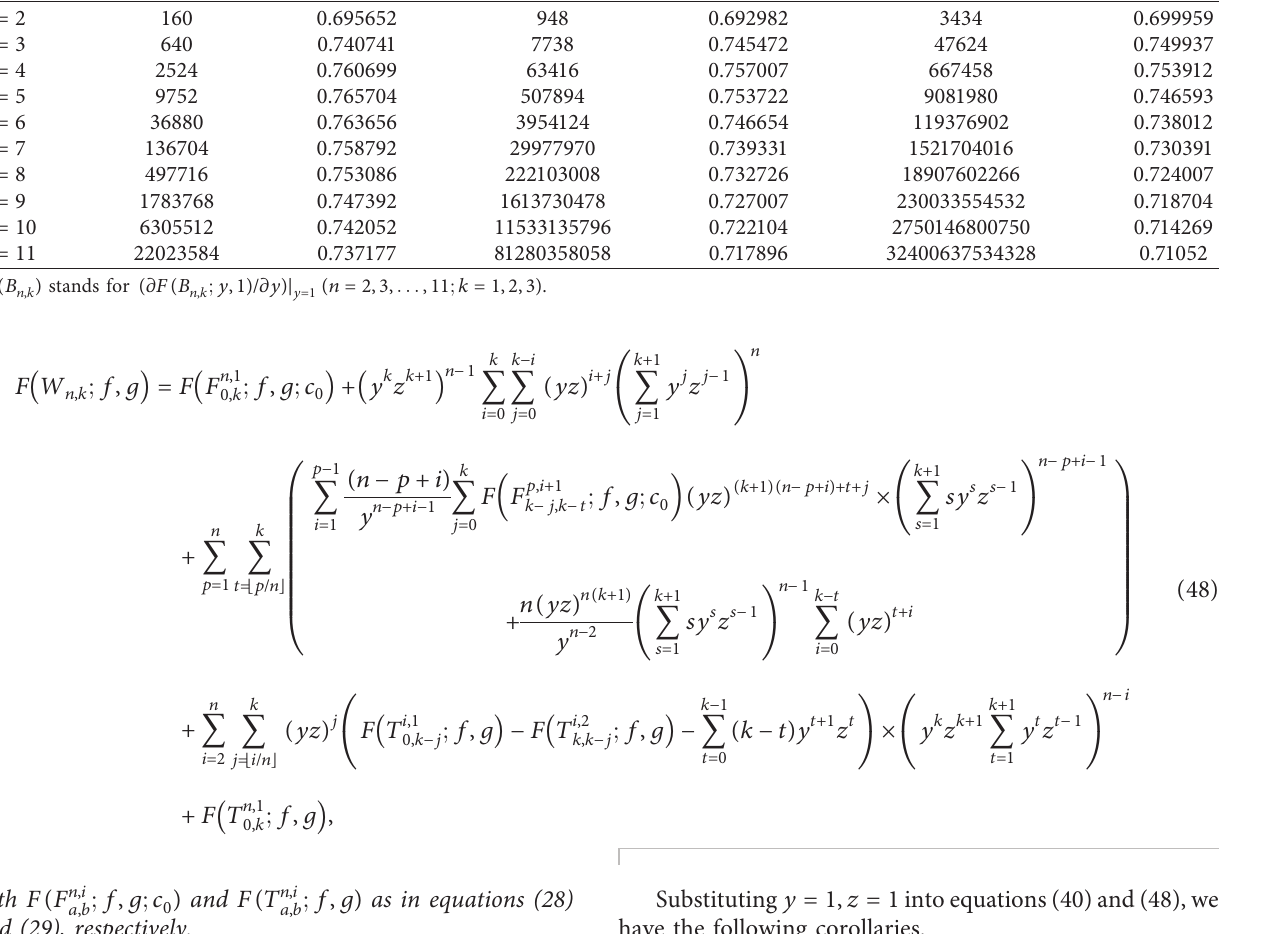
Table 4: Related data for B